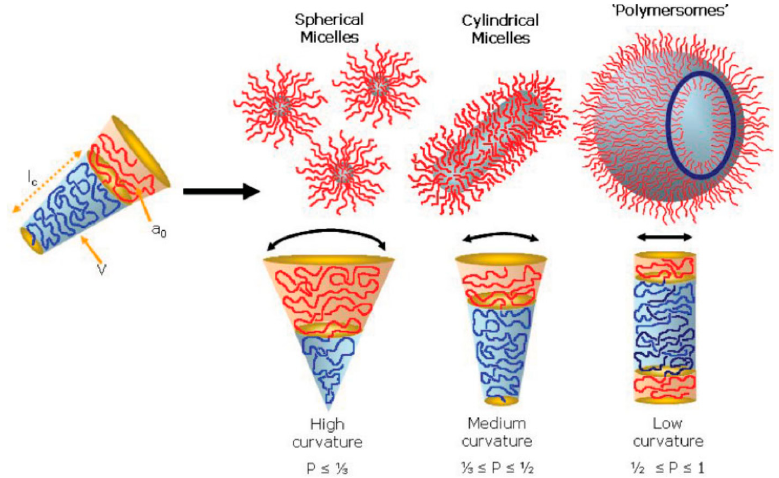
Figure 10. The types of formed nanostructures of amphiphilic diblock copolymers due to the inherent curvature of the polymer, as estimated by chain packing parameter, p. Reprinted from Reference [80]. (Copyright (2009) WILEY-VCH Verlag GmbH & Co. KGaA, Weinheim).